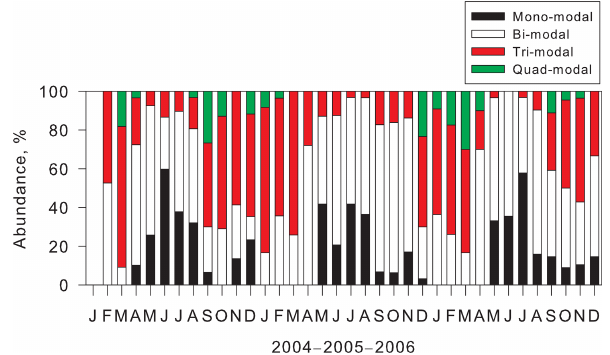
Figure 4. Seasonal features of abundance of modal structures ob- served at Syowa Station,